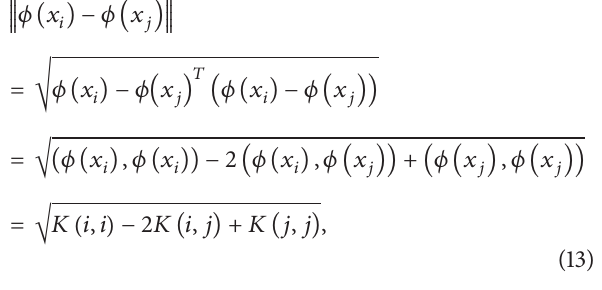
Algorithm 1. The formal algorithm procedure can be described as